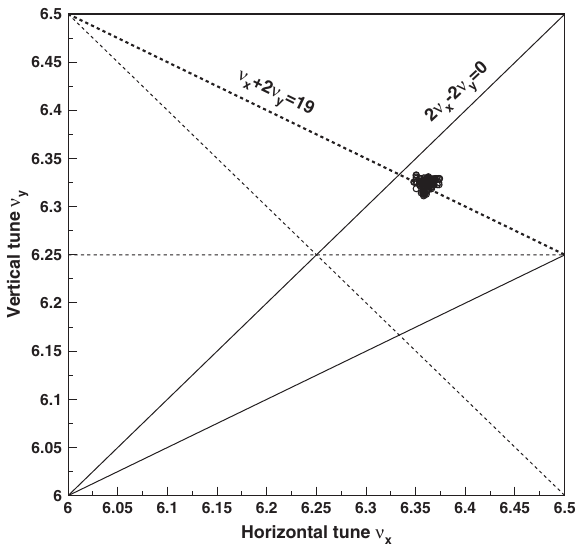
FIG. 14. Two-dimensional plot of the turn-by-turn incoherent tunes, calculated from the particle oscillations given in Fig. 12.